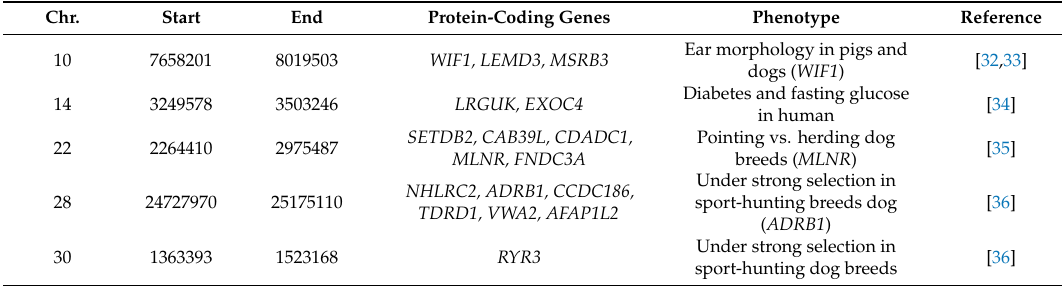
Figure 9. Manhattan plot of the distribution of ROH islands in 48 Istrian shorthaired hound genomes. The y -axis shows the number of overlapping ROH shared among individuals for each SNP. ROH islands, genomic regions where 70% or more samples shared ROH, were identified on chromosomes 10, 14, 22, 10, 14, 22, 28, and 30. 28, and 30. Table 5. ROH